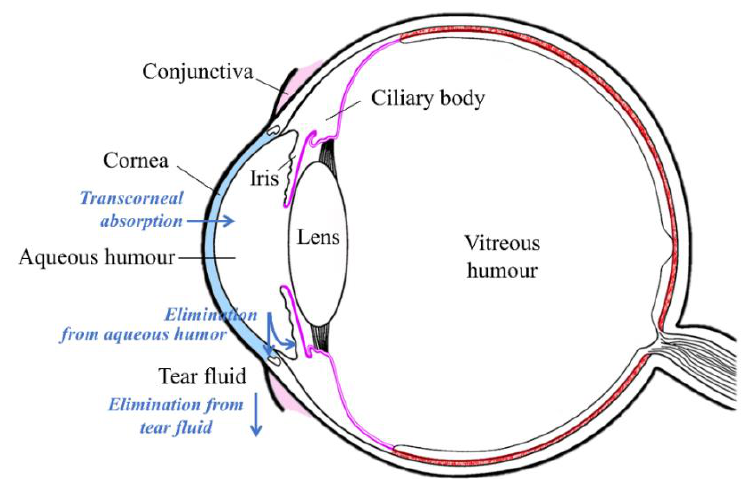
Figure 1. Illustration of topical ocular drug administration and pharmacokinetics. Drug concentrations in ophthalmic eyedrop solutions are usually in the range of 0.1%